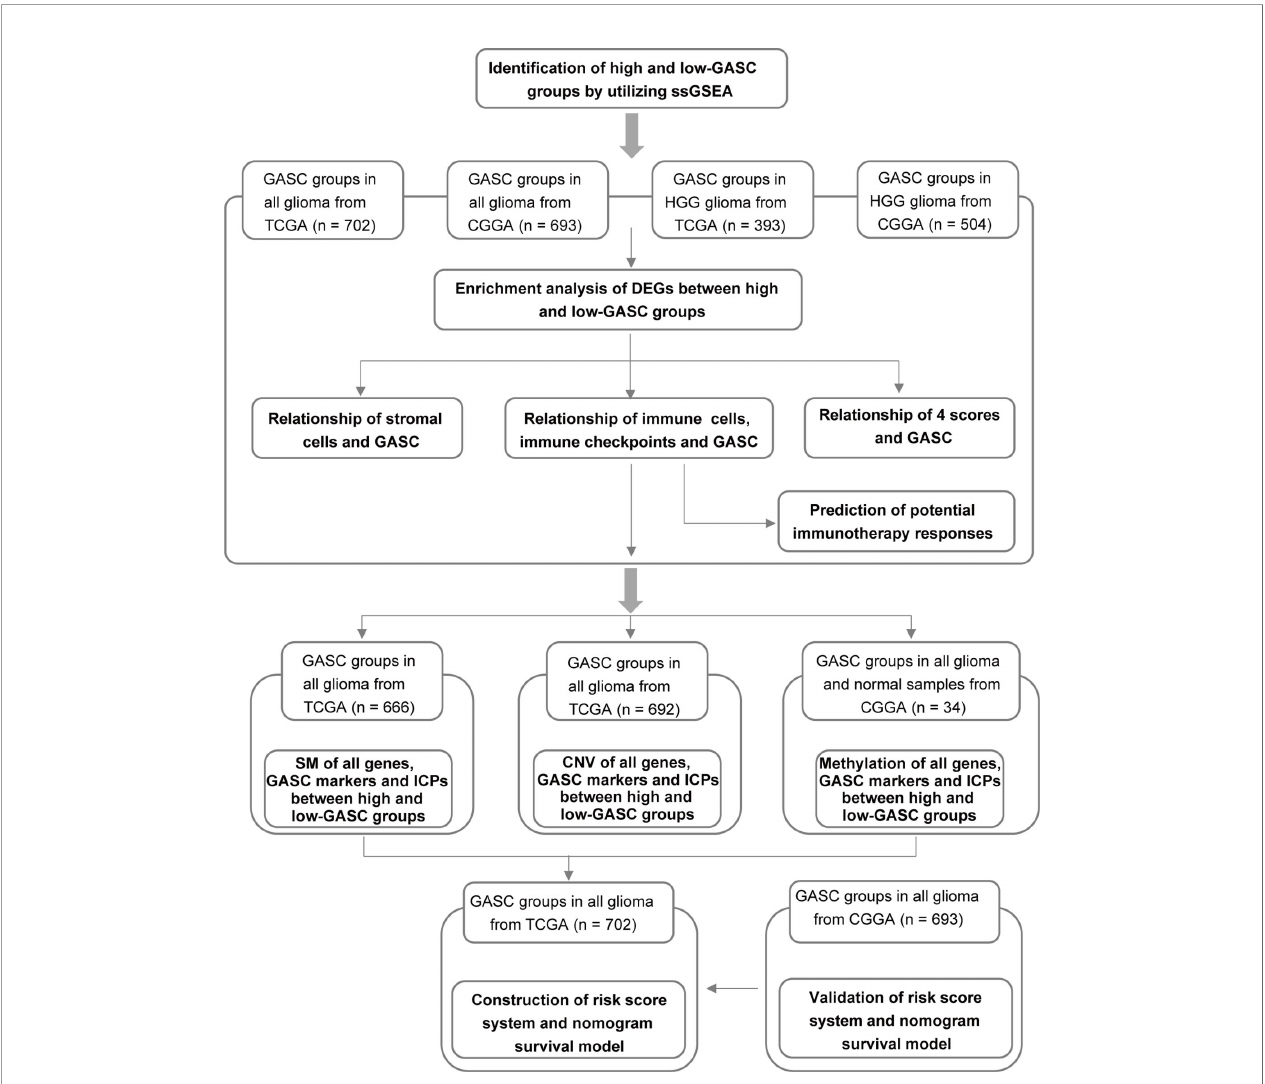
FIGURE 1 | Flow diagram of this investigation. HGG, high-grade glioma; DEGs, differentially expressed genes; 4 scores, stemness, mesenchymal-EMT, tumorigenic cytokine, and angiogenic activity scores; SM, somatic mutations; CNV, copy number variations; ICPs, immune